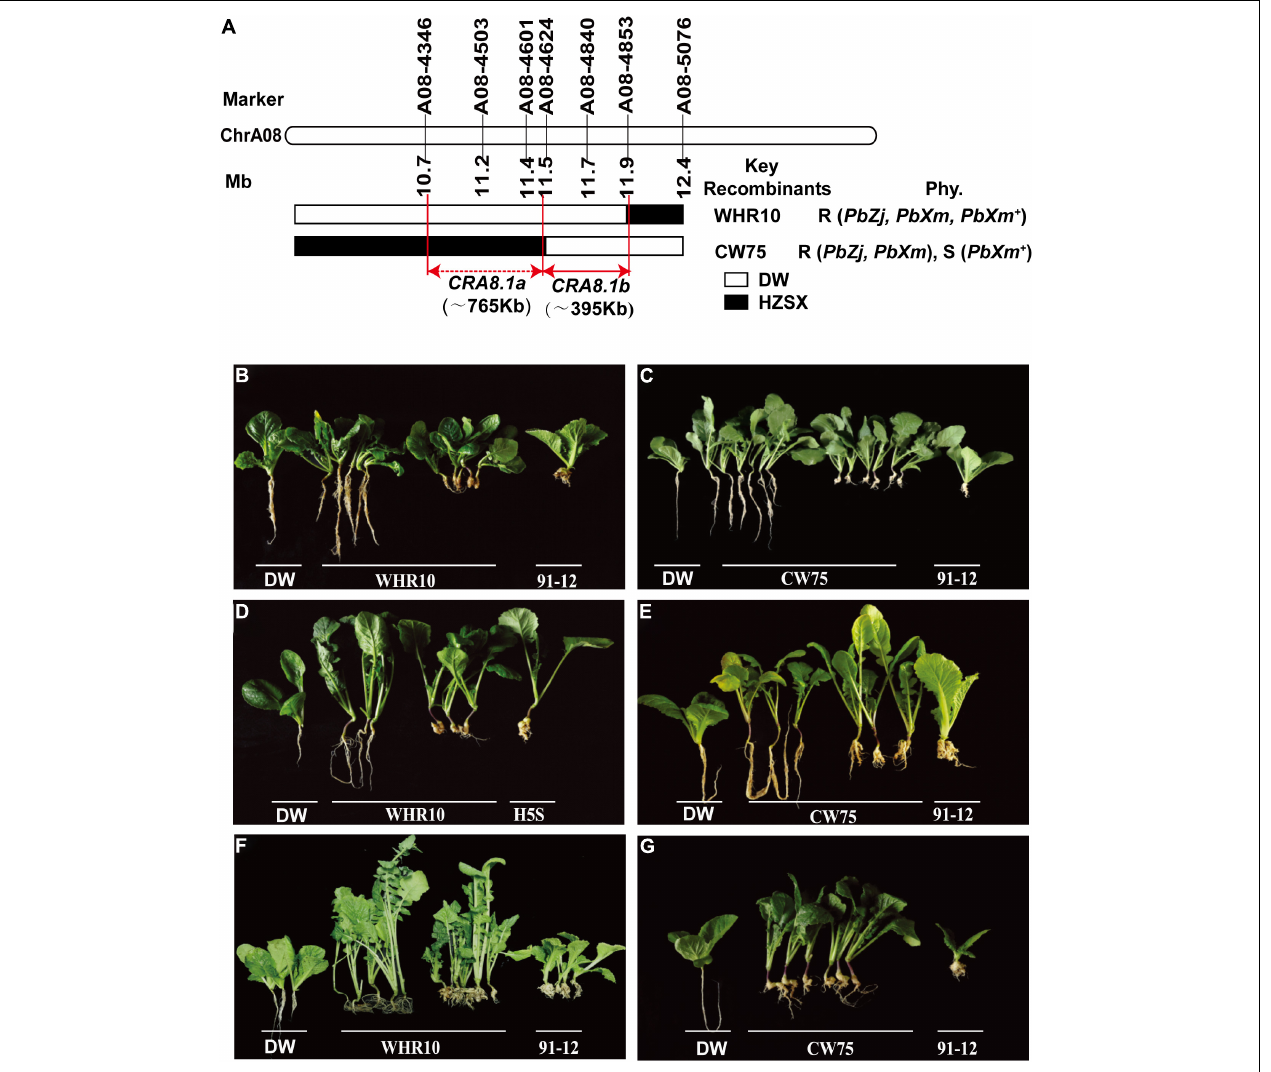
FIGURE 3 | CRA8.1a or CRA8.1b loci identified by fine mapping from A08-4346 to A08-4853 markers. (A) Genotyping of two representative recombinants CW75 and WHR10, carrying CRA8.1b or CRA8.1a and CRA8.1b , respectively. Disease phenotype of WHR10 and CW75 progeny plants after inoculation of PbZj (B,C)